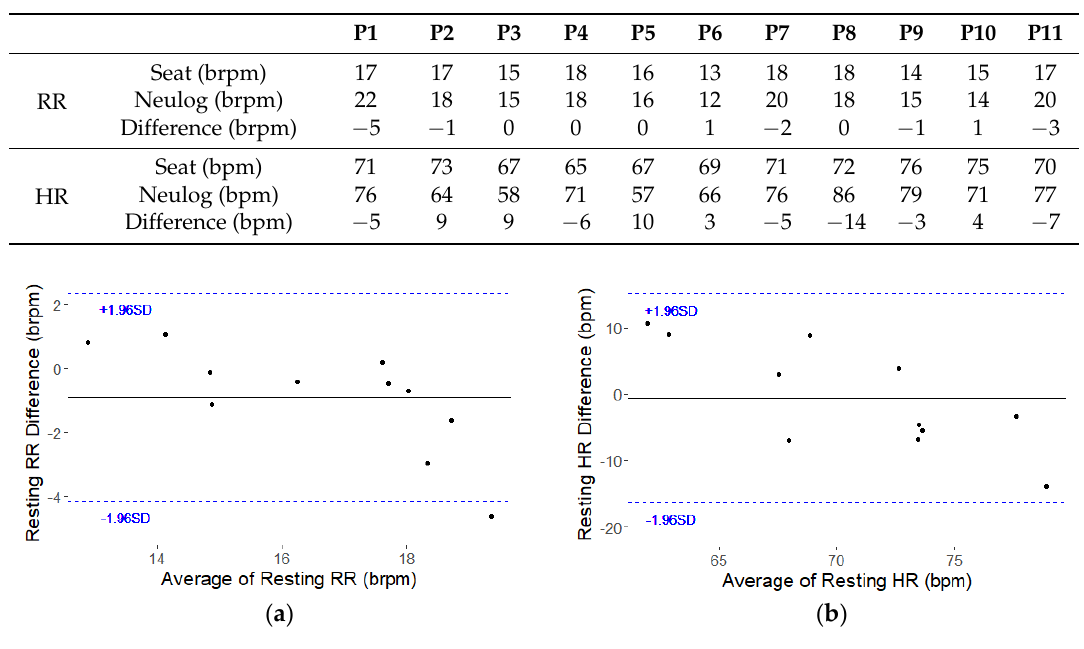
Figure 6. Bland ‐ Altman plots for resting RR ( a ) and resting HR ( b ). Difference between seat sensor and Neulog over the average of the two measures. Solid black line shows mean differences and dashed blue lines show 1.96 standard deviation bounds.